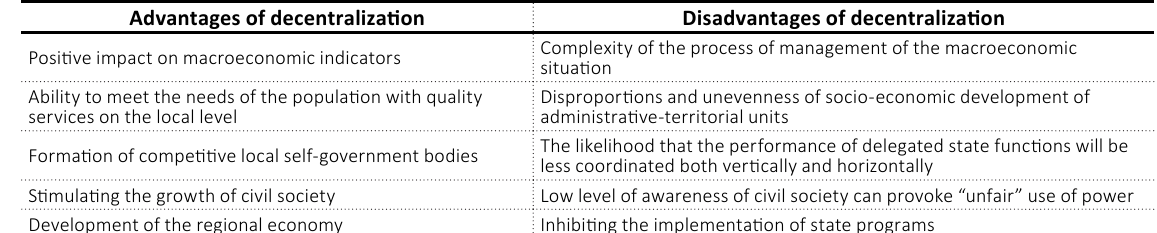
Table 1. Advantages and disadvantages of